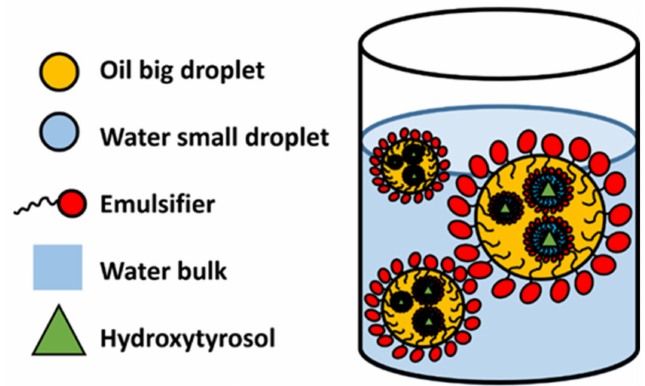
Figure 3. Schematic structure of double water-in-oil-in-water emulsion (DE) as possible system for hydroxytyrosol